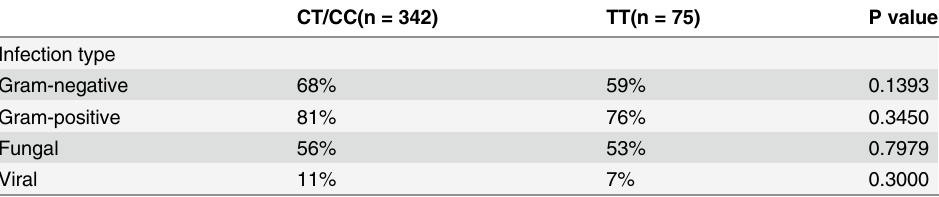
Table 4. Infection types over the observational